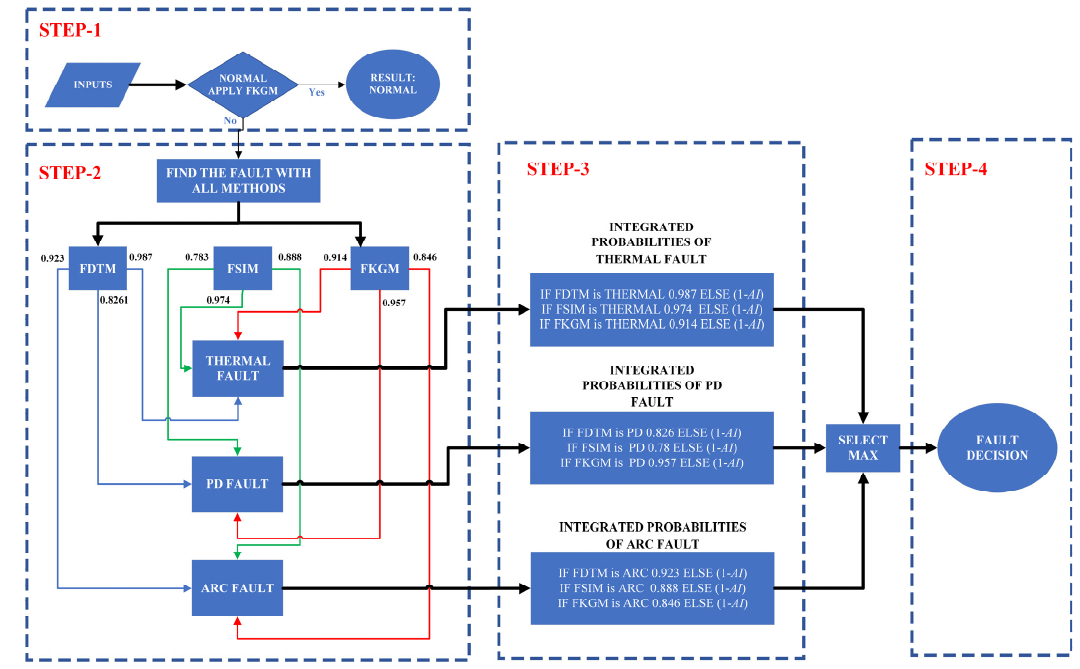
Figure 4. HCMS flow